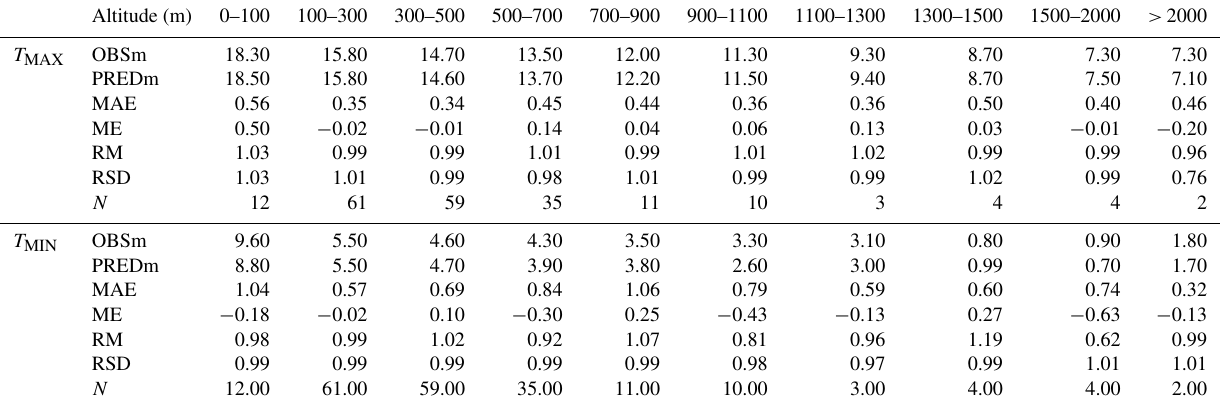
Figure 6. Comparison between measurements and estimates, by stations, of the mean maximum temperatures (a) and their 95th per- centiles (b) , and comparison of the mean minimum temperatures (c) and their 5th percentiles (d) . Dashed lines represent ± 1 standard deviation of the data. Table 4. The leave-one-out cross-validation (LOO-CV) statistics showing the goodness of fit between measurements and estimates of daily maximum and minimum temperature separated by altitudes (ma.s.l.). N : number of stations; OBSm: mean observed maximum and minimum temperature (maximum and minimum temperature in ◦ C); PREDm: mean predicted temperature ( ◦ C); MAE: mean absolute error ( ◦ C); ME: mean error ( ◦ C); RM: ratio of means; RSD: ratio of standard deviations. The results were rounded to two decimal places. Altitude